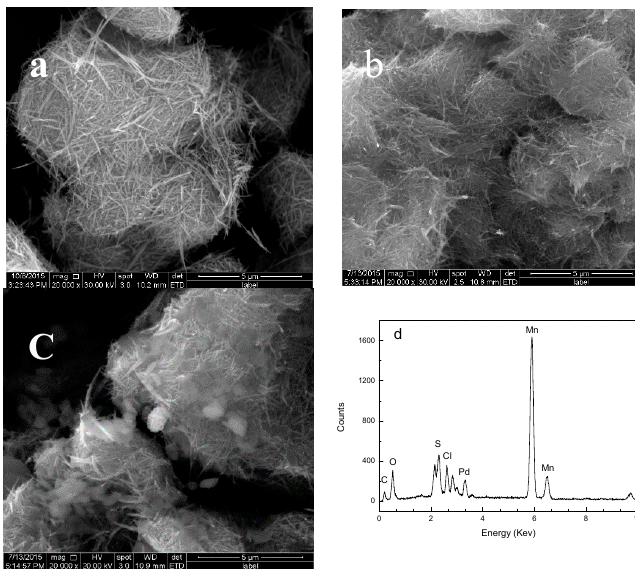
Figure 4. SEM images of ( a ) α -MnO 2 ; ( b ) BISIN; ( c ) Pd(II)-BISIN; and EDS spectrum of Pd(II)-BISIN ( d ).